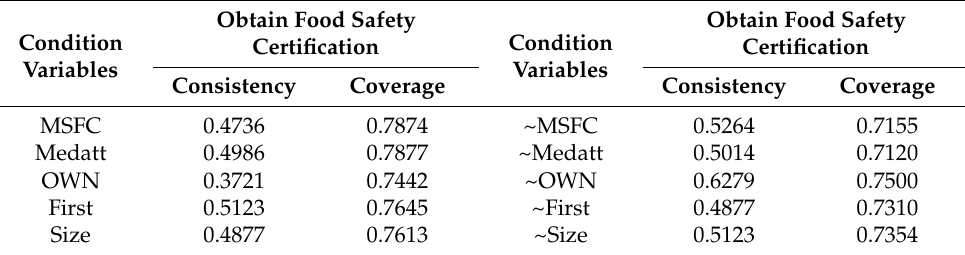
Table 4. Necessity analysis of single antecedent